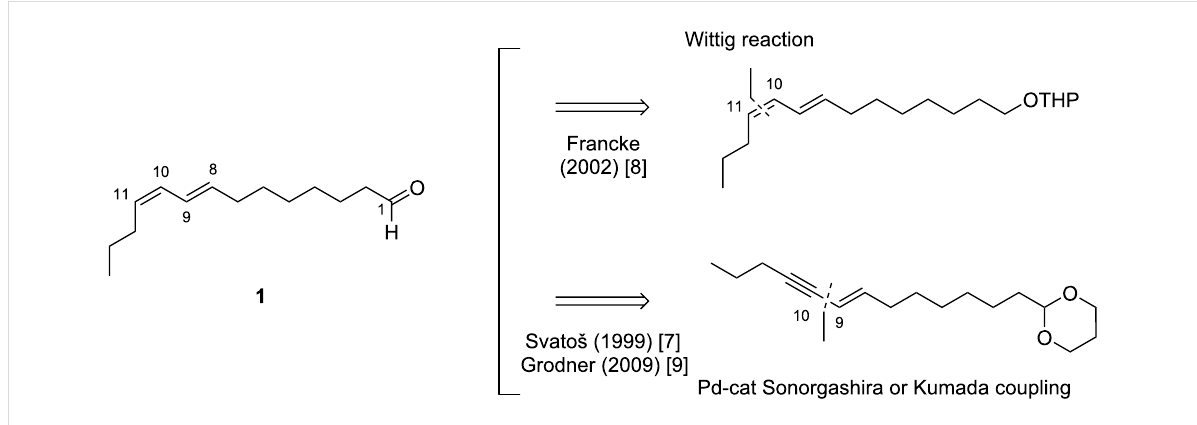
Scheme 1: Structure of the (8 E ,10 Z )-tetradecadienal ( 1 , sex pheromone of the horse-chestnut leaf miner) and reported retrosynthetic